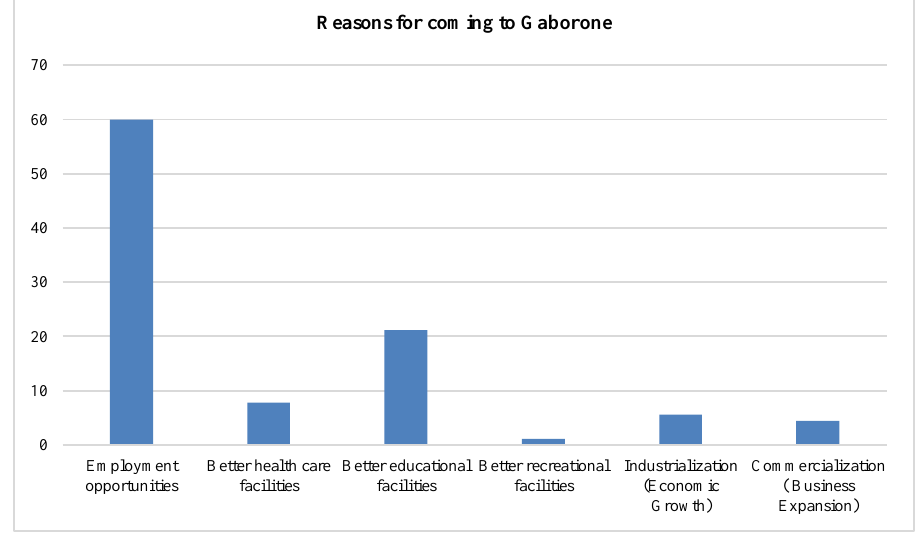
Figure 1: Reasons for coming to